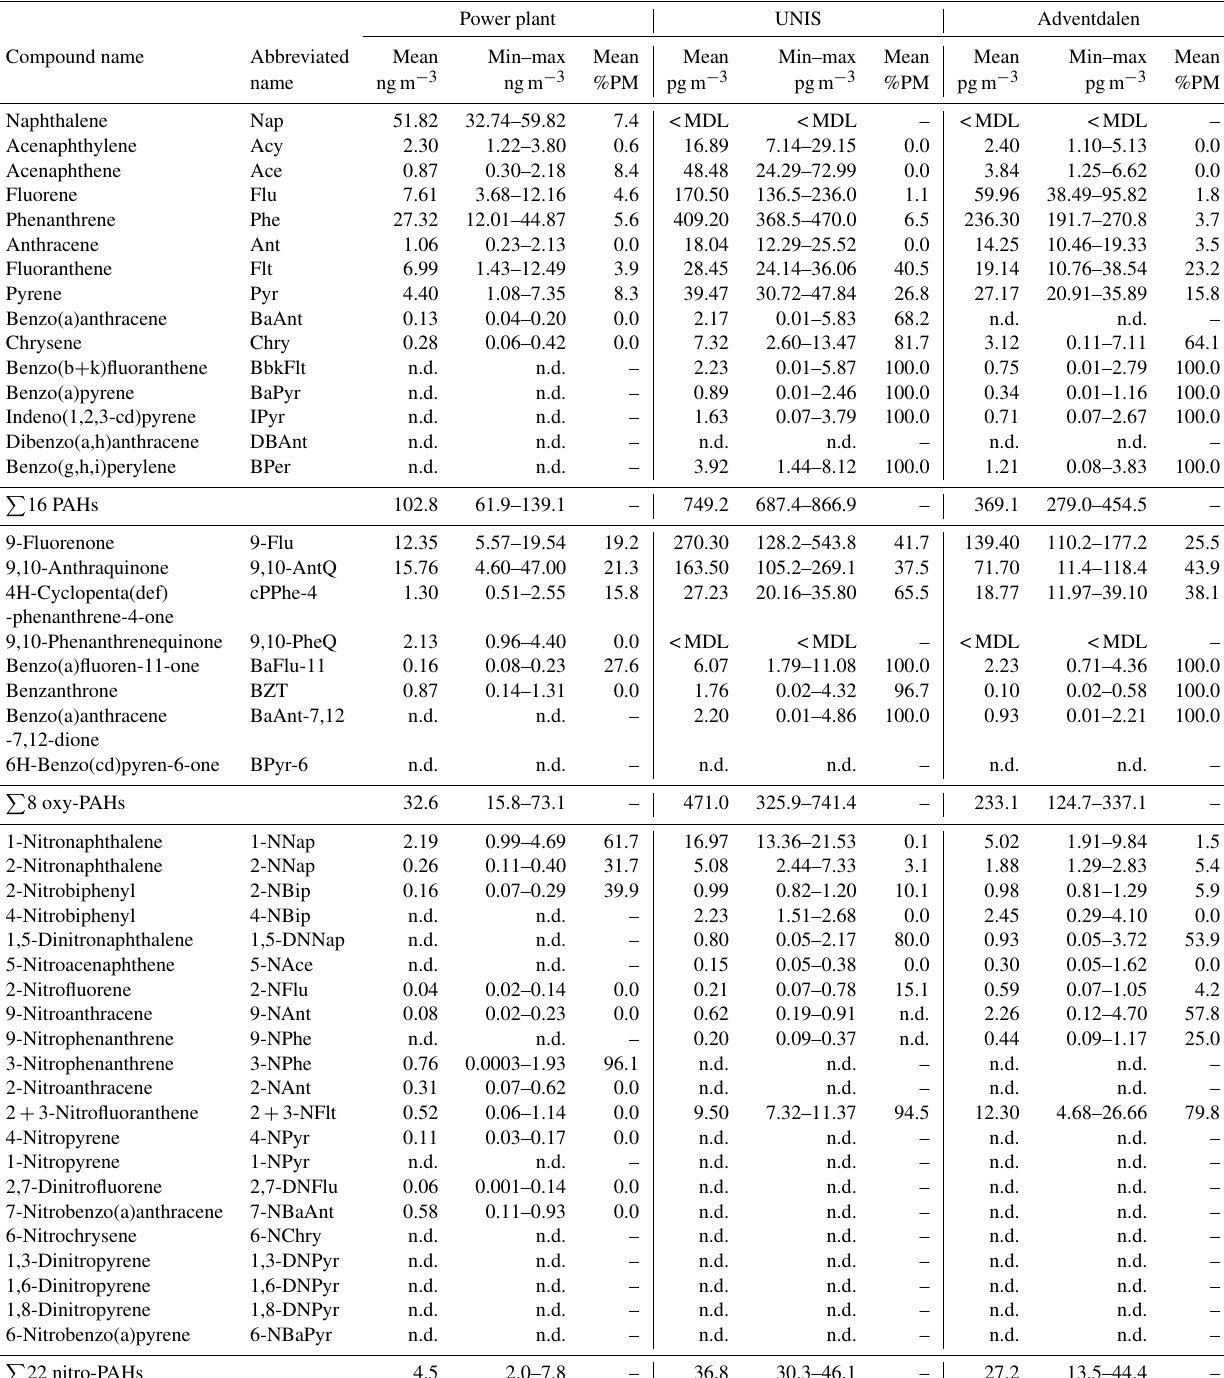
Table 1. Concentrations of PAHs (G + P) and percentage in the particulate phase (%PM) in Longyearbyen power plant, UNIS, and Advent- dalen. Data are average, minimum, and maximum; n = 6 for each location.